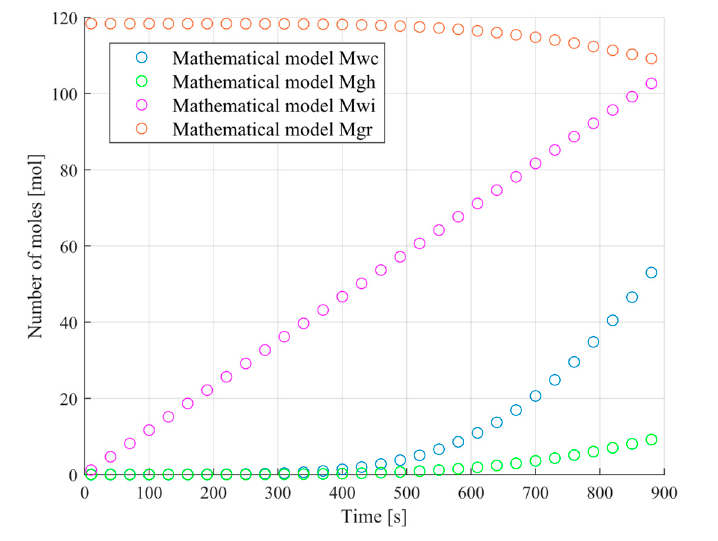
Figure 3. Changes in reactor components over time as predicted by a mathematical model.